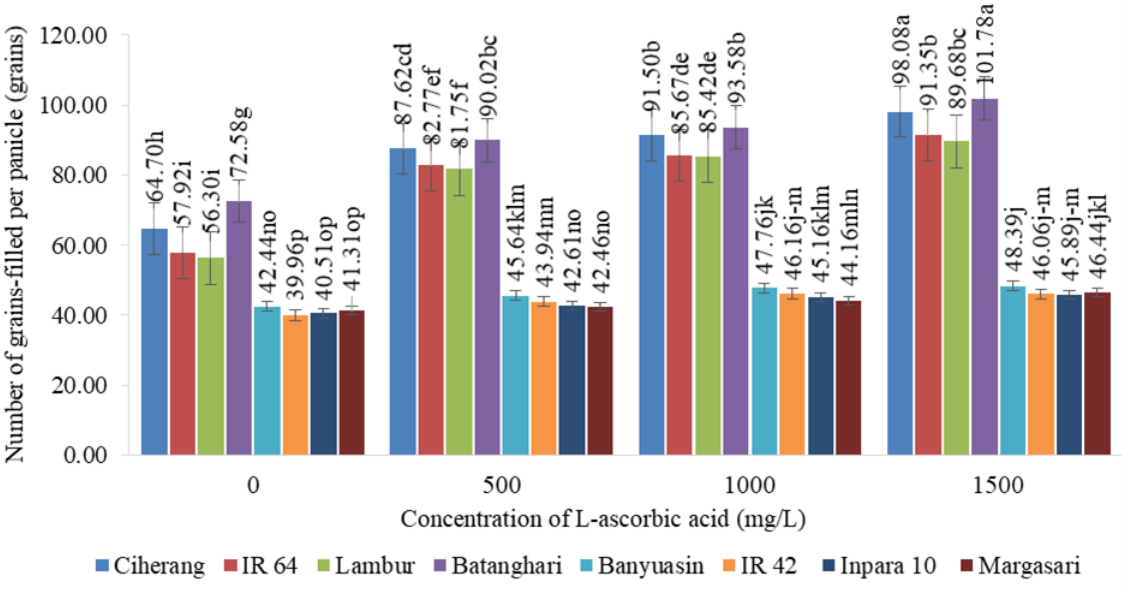
Figure 4 Effect of -ascorbic acid treatment on the number of filled grains per panicle of eight rice varieties grown under salinity stress. e mean values followed by different letters indicate significant difference between treatments according to Duncan’s